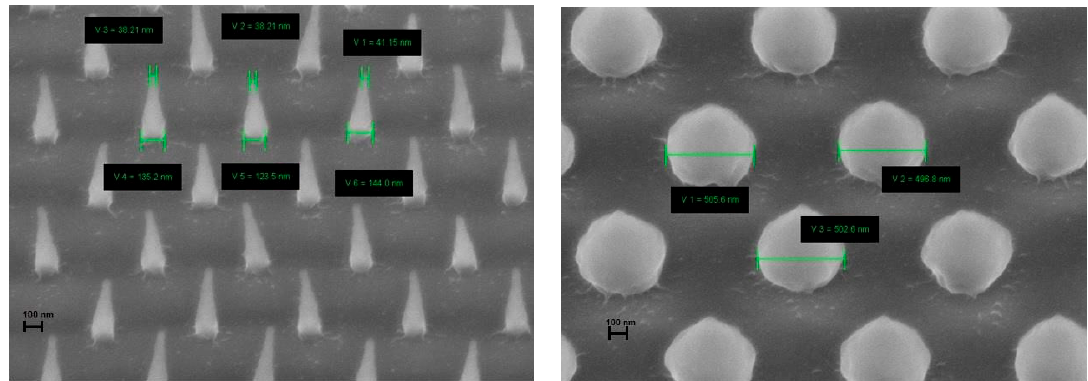
Figure 2. Spiky ( left ) and rounded ( right ) SU-8 nanostructures fabricated using optimized e-beam lithography parameters. Scale bars represent 100